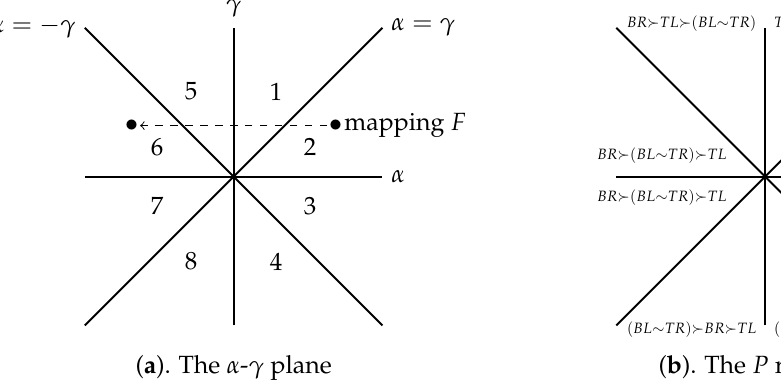
Figure 2. The α , β , γ